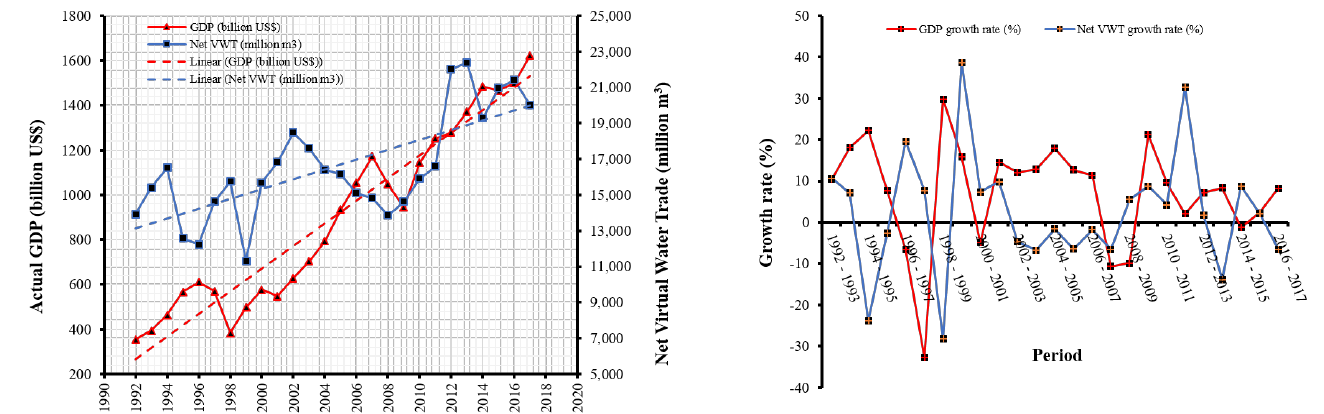
Figure 5. The change trend of grain net virtual water trade and economic growth (GDP) in South Korea (1992–2017) [first graph shows the trend of actual GDP against net virtual water trade; second graph shows the growth rates of actual GDP and net virtual water trade].